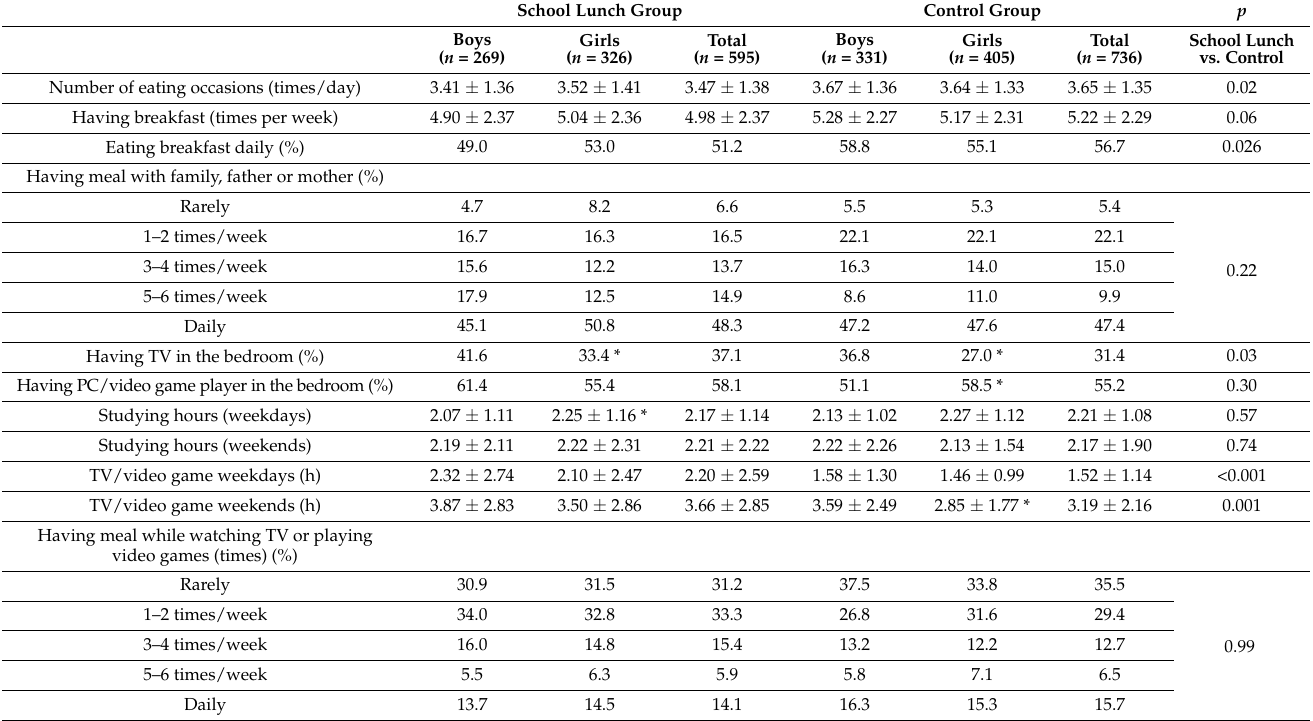
Table 2. Eating habits and sedentary lifestyle characteristics of the population.